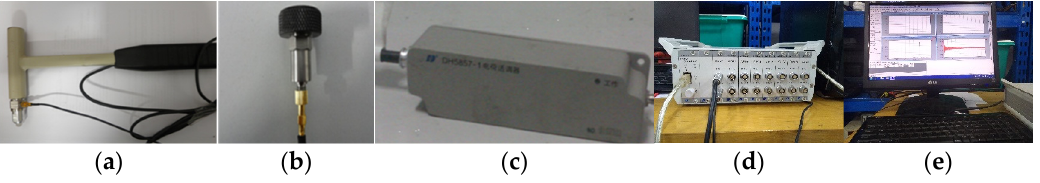
Figure 7. The experimental setup: ( a ) hammer; ( b ) accelerometer sensor; ( c ) charge adapter; ( d ) dynamic data acquisition instrument; (e) computer.